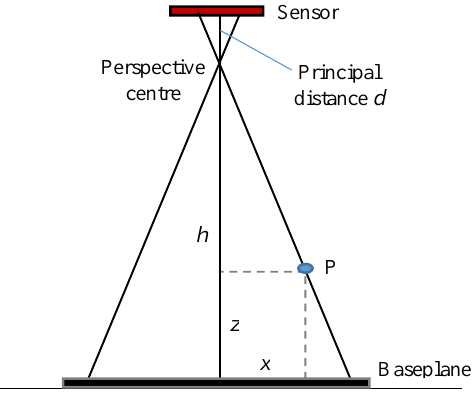
Figure 13. Geometry of projection of points onto image sensor.